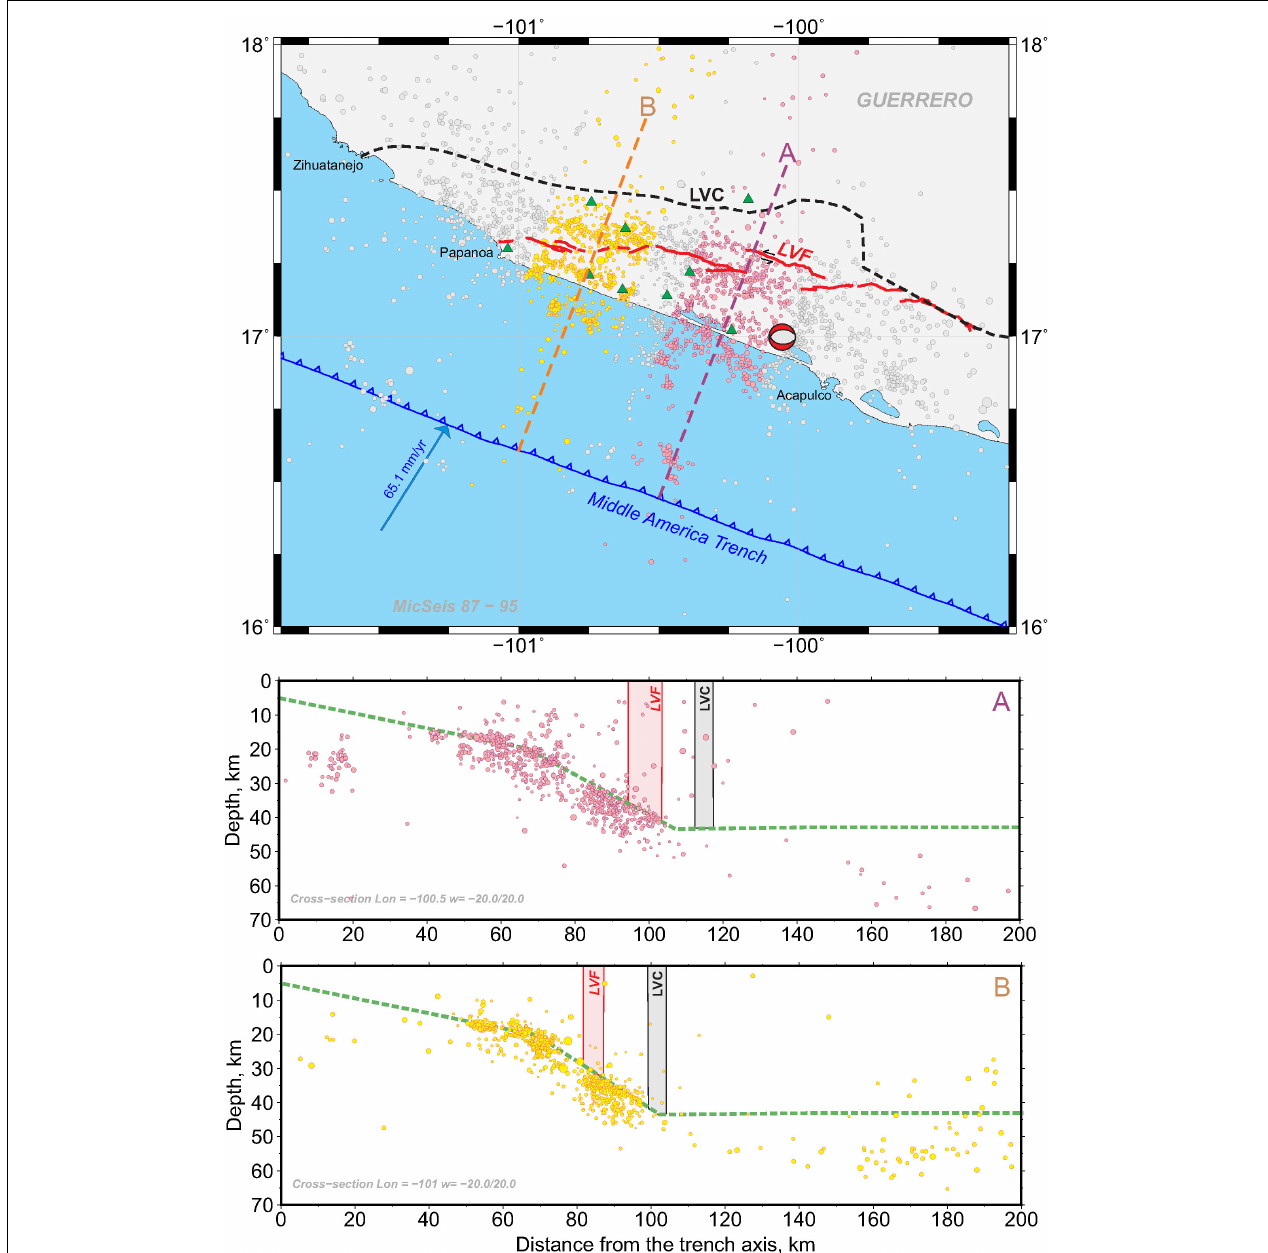
FIGURE 6 | Top map: seismicity in the Guerrero seismic gap area from the local network catalog [1987–1995, 1.0 < Mc < 4.0, (Suárez et al., 1990)]. Green triangles are locations of short period seismometers of the network. LVC, black dashed line shows location of the La Venta–Chacalapa fault zone from geological studies (Tolson, 2005; Solari et al., 2007). Red lines denote a trace of the La Venta fault, LVF, according to Gaidzik et al. (2016). Dashed lines A and B perpendicular to the trench mark two profiles on which the seismic events from the catalog were projected. The events in each cross-section, yellow and magenta on the map, are from the bands of 40-km-wide, centered along the profiles. Red-white focal mechanism shows a location of the October 8, 2001 Coyuca, Mw 5.8, Earthquake (Pacheco and Singh, 2010). A: seismicity cross-section along the profile A (magenta line and events on the map). Pink trapezoid shows roughly a projection of the LVF zone assuming that the fault is vertical. Gray rectangle is a projection of the LVC fault zone assuming that the fault is vertical. Green dashed line is an approximation of the plate interface. B: seismicity cross-section along the profile B (yellow line and seismic events on the map). Other notations are the same as for the cross-section A.